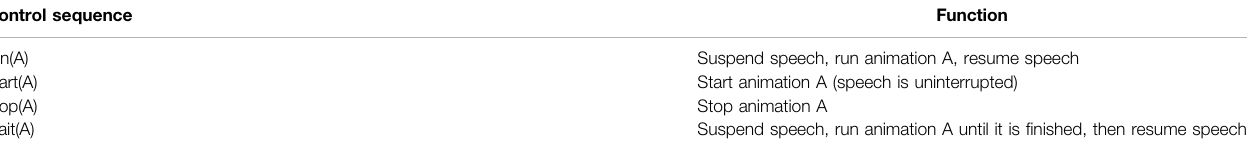
TABLE 3 | Control sequences for execution of animations that may be mixed with regular text in sentences. Control sequence